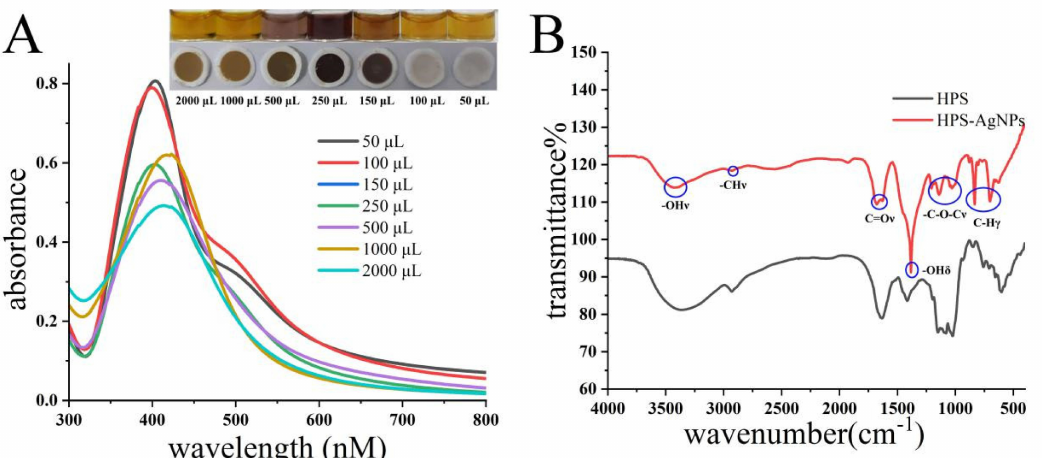
Figure 1. ( A ) The photographs and UV spectra of AgNPs with different doses of HPS. ( B ) The FT-IR spectra of HPS and